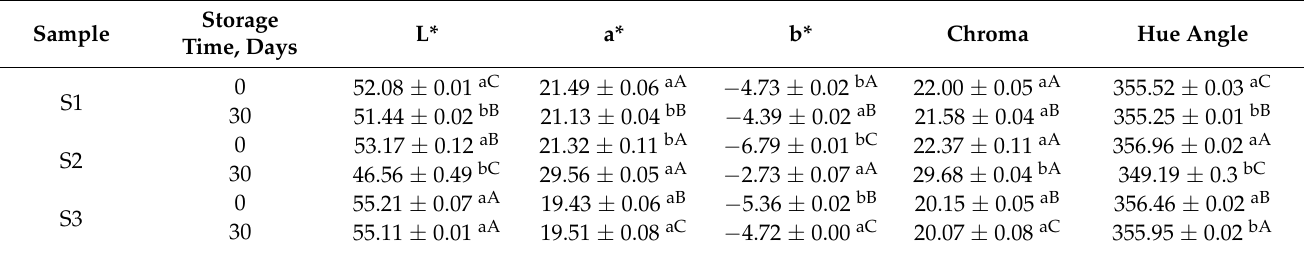
Table 2. Color coordinates of the microcapsule